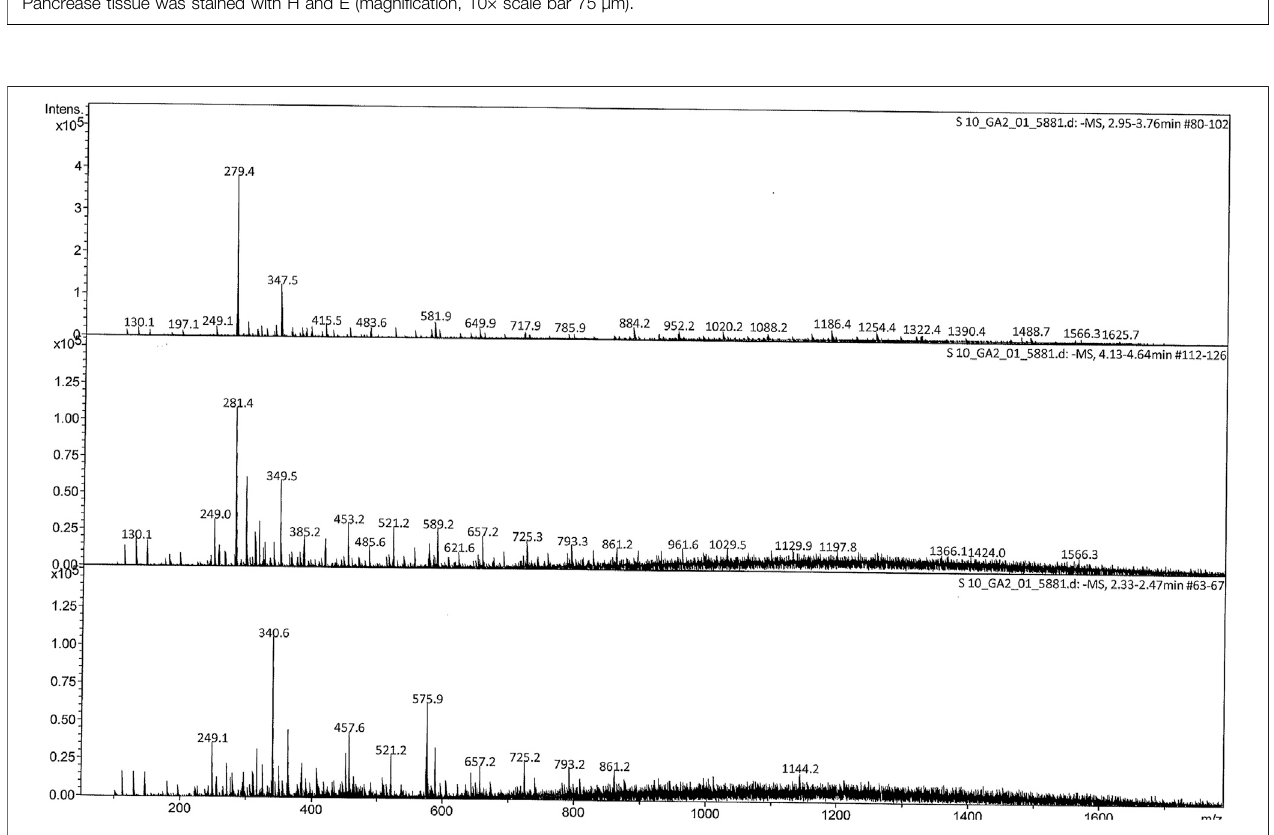
FIGURE 4 | ESI mass spectrum (-MS) of M. conica at 2.95 – 3.76, 4.13 – 4.64, and 2.33 – 2.47 min full scan (200 – 1800 m /z ).